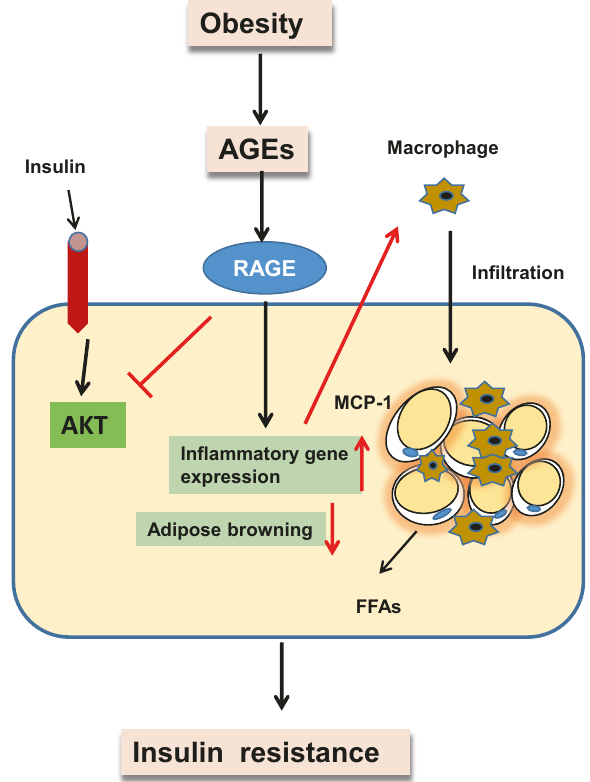
Fig. 4 Proposed model by which RAGE mediates glucose home- ostasis in adipose tissue. Schematic diagram illustrating potential mechanisms by which RAGE affects systemic glucose homeostasis through inhibition of circulating monocyte recruitment to visceral AT and downregulation of the M1 population of macrophages. In the absence of RAGE signaling, decreased FFA production and enhanced AT browning are also suggested to provide a protective effect against increased systemic insulin resistance. FFAs, free fatty